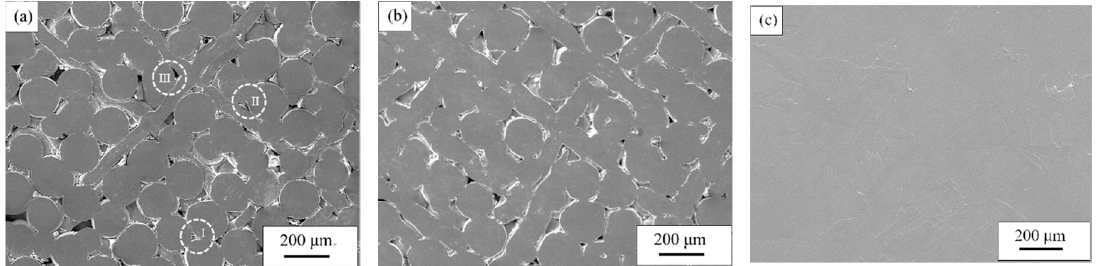
Figure 3. SEM micrographs of samples sintered at different sintering temperatures: ( a ) 800 °C, ( b ) 900 °C and ( c ) 1000 °C.